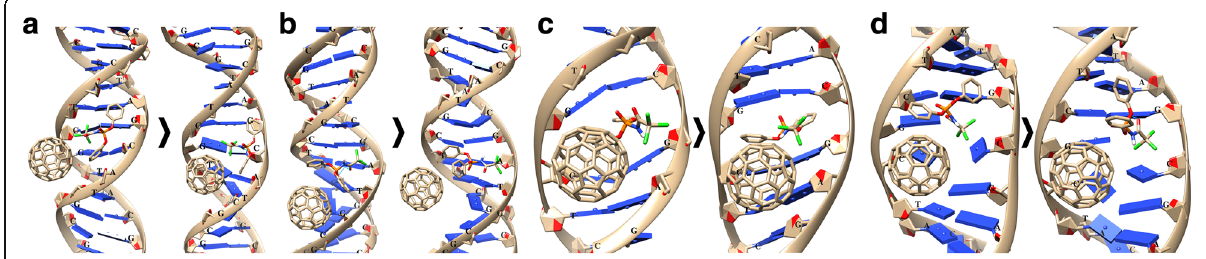
Fig. 4 Combined interaction of diphenyl-N-(trichloroacetyl)-amidophosphate (HL) and C 60 fullerene with DNA (HL+C 60 or C 60 +HL versions): a , b binding with minor and major grooves, c , d intercalation into minor and major grooves. The used DNA structures of the PDB database: a , b — 2M2C, c — 1XRW, and d —